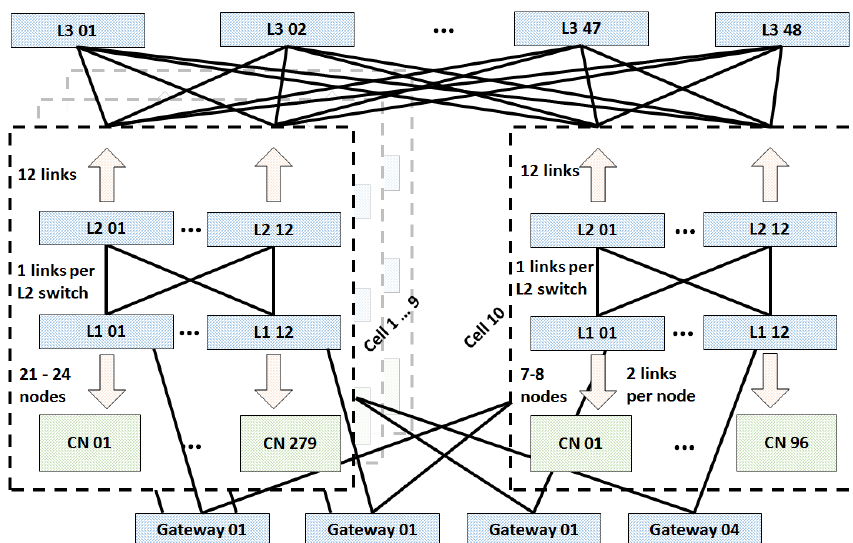
Figure 4: Schematic of the JUWELS InfiniBand network topology. Please note that the 10th cell is only half populated in the current deployment. Each cell is connected to each gateway switch with at least one link. Various service nodes that are connected to free ports in the level one switches are not